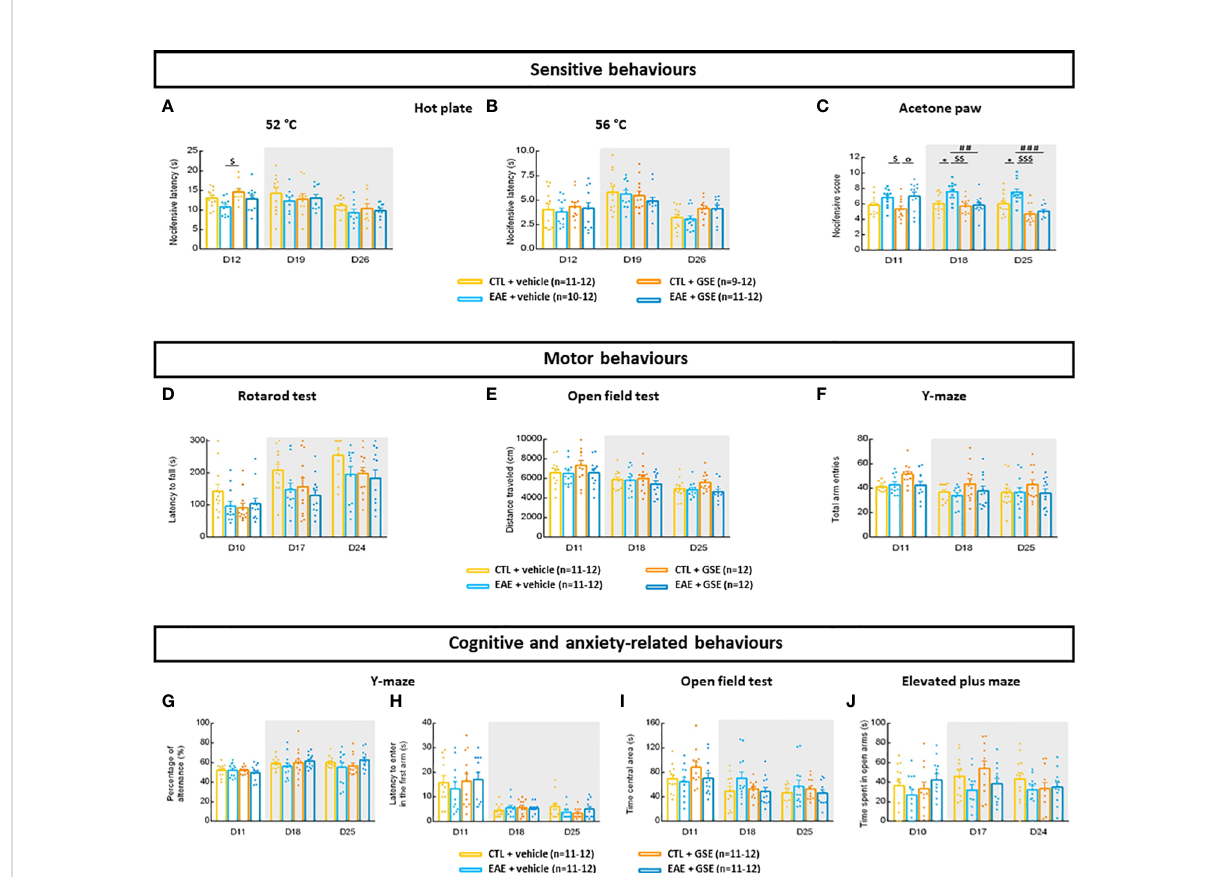
FIGURE 2 Evaluation of sensitive, motor, cognitive, and anxiety-related behaviors in experimental autoimmune encephalomyelitis mice (EAE) and their controls (CTL) after curative treatment with grape seed extract (GSE) or vehicle. (A, B) Evaluation of heat hyperalgesia using the hot plate test expressed as the mean time taken to observe a nocifensive behavior in mice exposed to a thermal plate maintained at 52°C (A) or 56°C (B) . Data are expressed as mean nocifensive latency ± SEM. (C) Evaluation of cold allodynia using the acetone paw test expressed as the mean number of nocifensive response ± SEM observed in mice after acetone drop deposition. (D) Evaluation of motor coordination using rotarod test, expressed as the mean latency to fall ± SEM for the four-rotarod sessions performed by each mouse. (E) Evaluation of spontaneous locomotor activity using the open fi eld, expressed as the total distance travelled ± SEM for the overall 15-min session. (F) Evaluation of spontaneous locomotor activity using the Y-maze, expressed as the total number of arm entries ± SEM for the overall 10-min session. (G, H) Evaluation of working memory and anxiety-related behaviors using the Y-maze. The working memory was evaluated using the percentage of alternation ± SEM for the overall 10-min session (G) and anxiety-related behaviors were evaluated using the time spent to enter the fi rst new arm ± SEM during the overall 10-min session (H) . (I) Evaluation of anxiety-related behaviors using the open- fi eld test expressed as the time spent in central area ± SEM for the overall 15-min session. (J) Evaluation of anxiety-related behaviors using the elevated plus maze (EPM), expressed as the time spent in the open arms ± SEM for the overall 10-min session. Shadowed area represents times of evaluation after GSE treatment induction. Statistical analysis was performed using two-way ANOVA followed by post-hoc Sidak ’ s test: *p < 0.05 EAE + vehicle vs CTL + vehicle; ##p